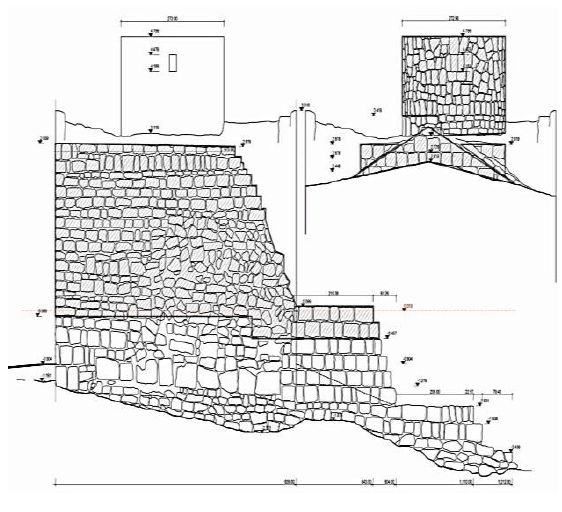
Figure 8. Western facade